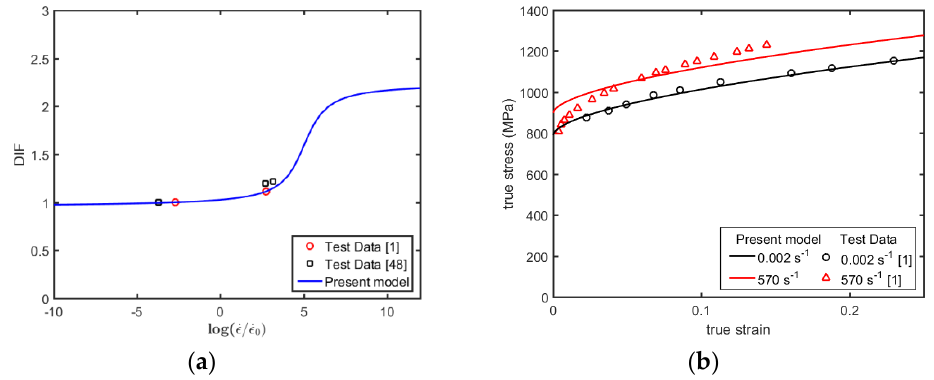
Figure 4. Comparison of the present model with the test data for OFHC copper. ( a ) DIF versus strain rate at a plastic strain of 0.15 in tension and compression at room temperature; and ( b ) true tress-true strain curves in compression.